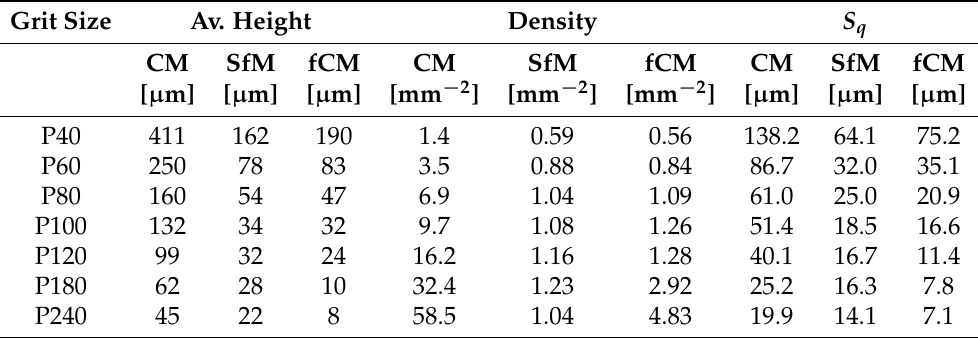
Table 5. Parameters from CM, SfM at a range of 1.7 m and filtered CM (fCM). Values shown are the average particle height, the particle surface density and the S q roughness